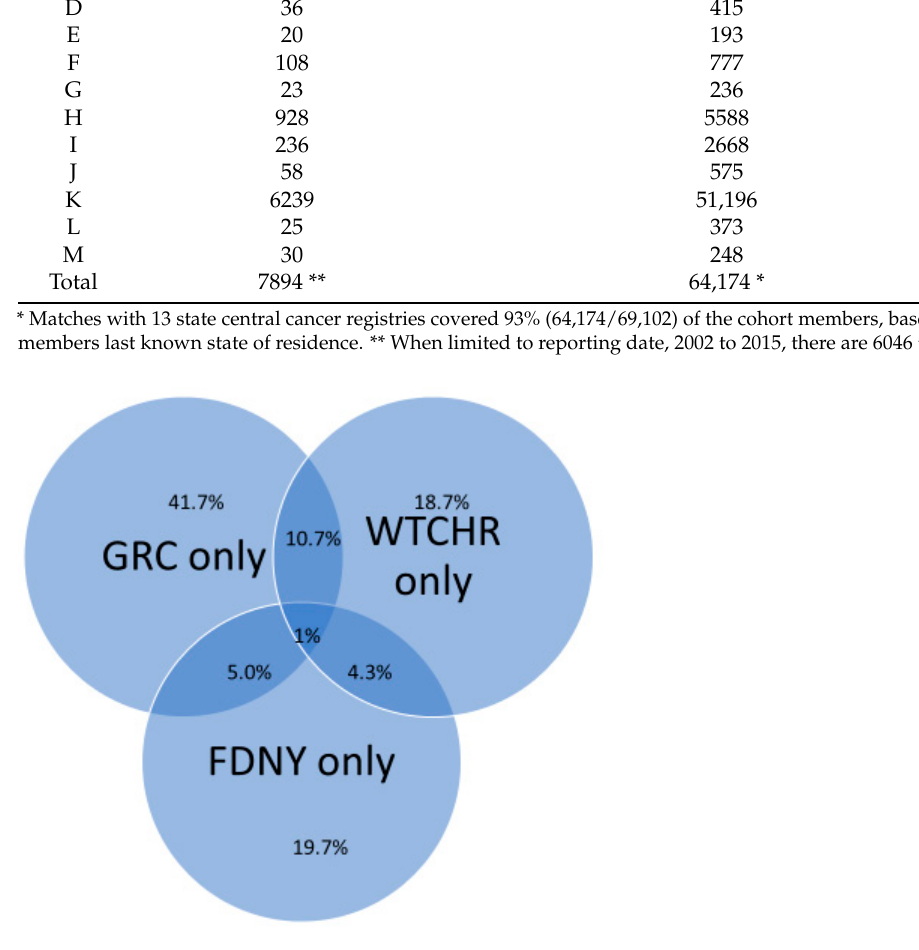
Figure 3. Distribution of cancer cases across the three cohorts after joining and matching with state cancer registries. These are cancer cases reported between 2002–2015 for the 64,174 rescue/recovery workers who reported at last known address in one of the 13 states with which data was linked. N = 6046.